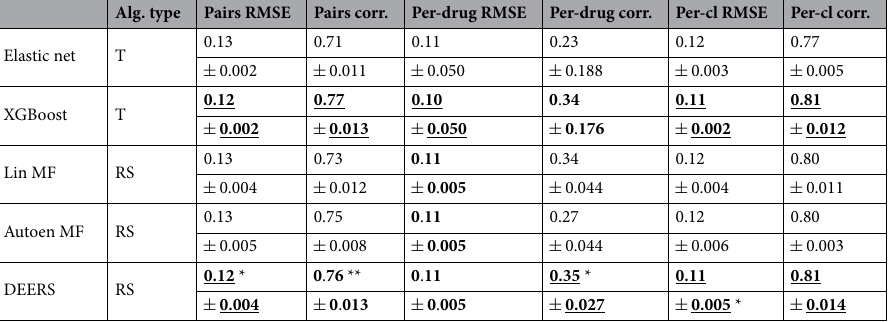
Table 2. Predictive performance of DEERS and compared models when using AUC as a drug response metric. Table columns and formatting the same as in Table